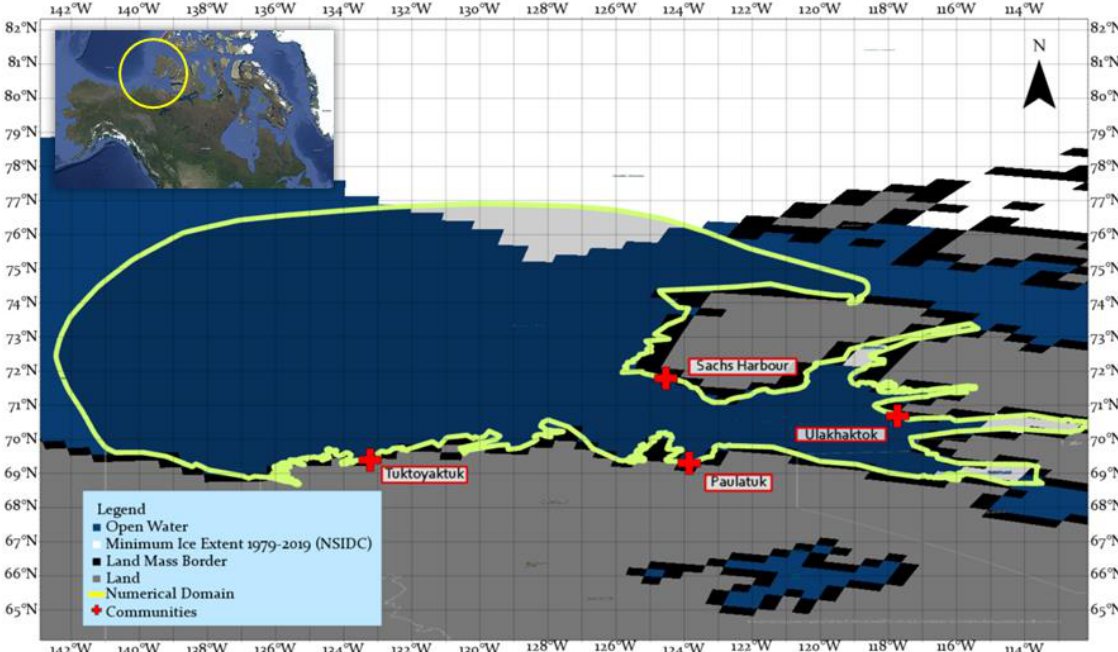
Figure 2. Hydrodynamic model computational domain overlaid over the minimum sea ice extent during the period of 1979–2019. Map data from Google [26].